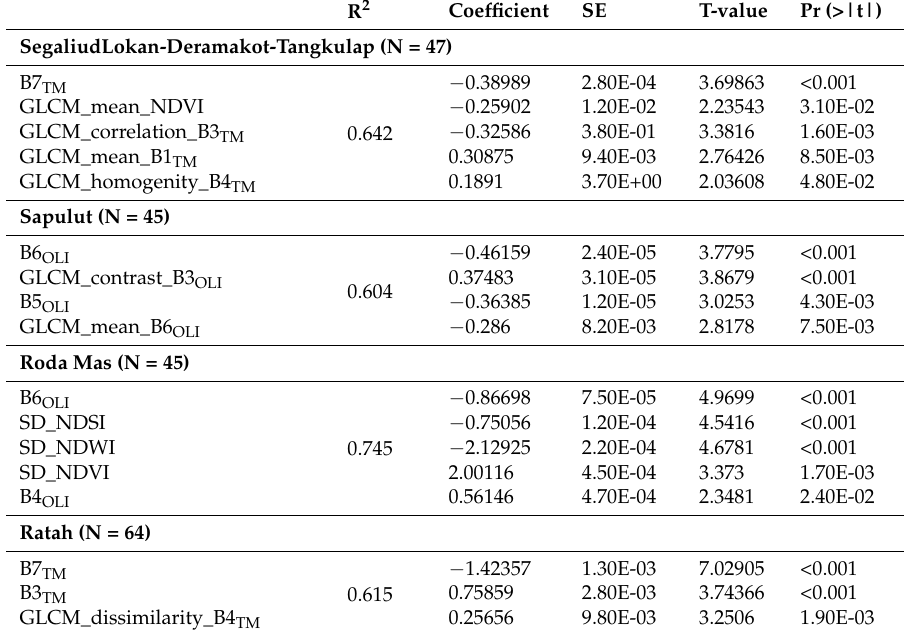
Table 2. Description of established multivariate regression models based on all